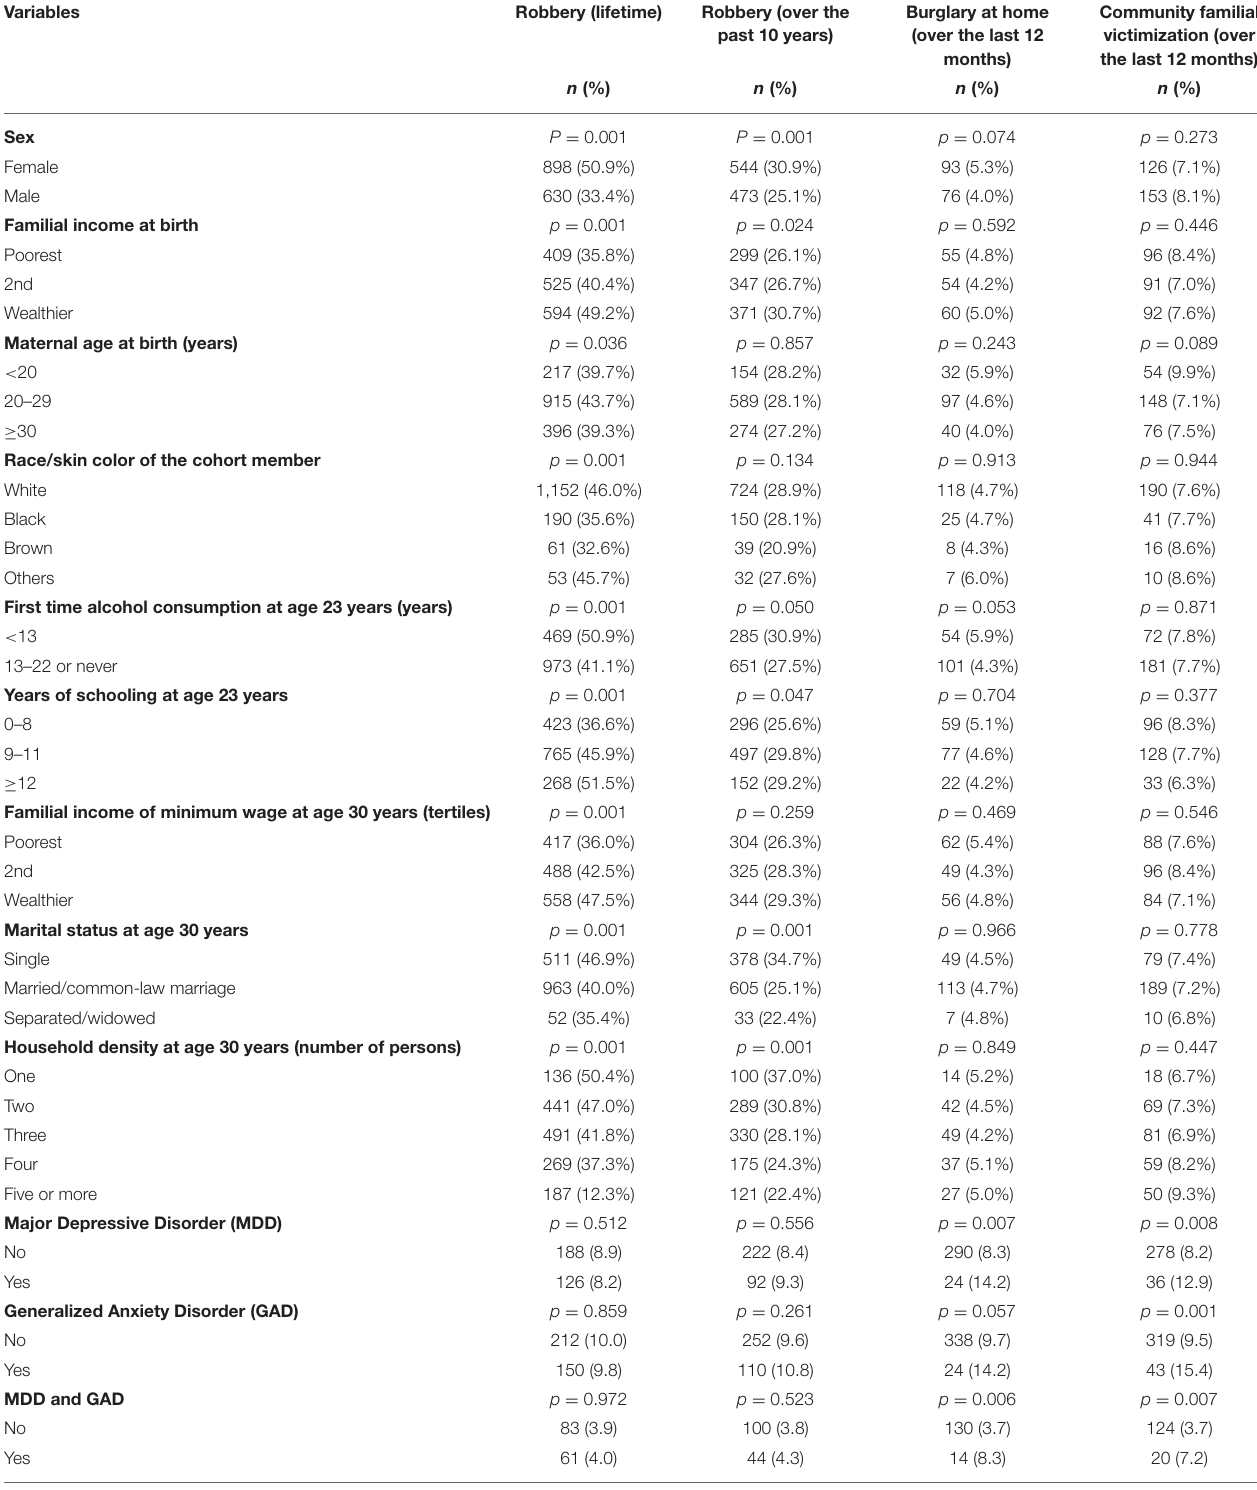
TABLE 3 | Frequency of robbery victimization, according to sociodemographic, perinatal, lifestyle and mental disorders at age 30 years, 1,982 Pelotas birth cohort, Brazil. Variables Robbery (lifetime) Robbery (over the